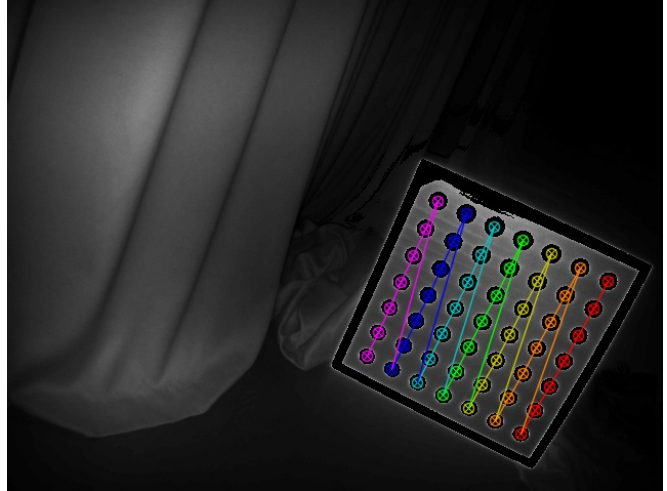
Figure 5. The extraction result of the circle center of the calibration plate in the intensity image. For the 2D points ( ) l l , u v in the left camera image coordinate system and the corre- sponding 3D point ( ) , , X Y Z p p p in the point cloud coordinate system, the following rela-